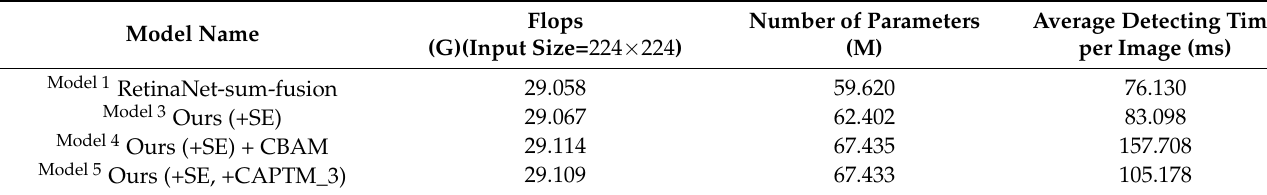
Table 5. The floating point operations (FLOPs), the number of parameters and the average detection time per image of different models.